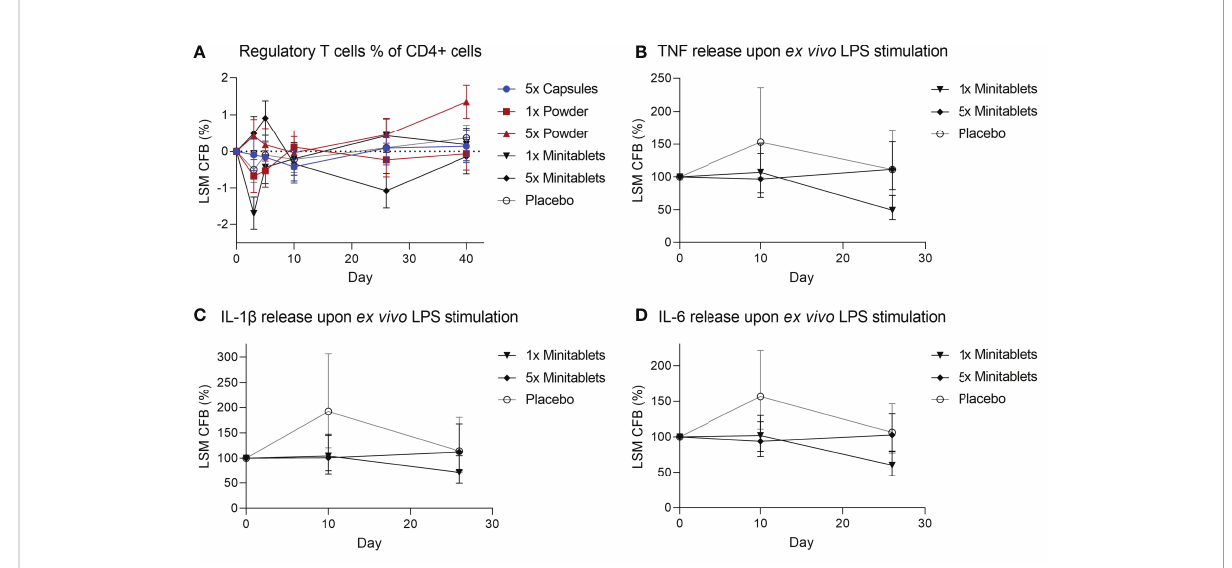
FIGURE 4 (A) Circulating regulatory T cells as percentage of CD4 + T cells from heparinized blood. Monocyte cytokine release assay of (B) tumor necrosis factor, (C) interleukin-1 b , and (D) interleukin-6 release from whole blood cultures after ex vivo lipopolysaccharide stimulation. X-axis represents number of days after initial EDP1066 dose. Data are shown as least squares mean change from baseline ( CFB) with 95% con fi dence interval. LSM, least squares mean; CFB, change from baseline; LPS, lipopolysaccharide; TNF, tumor necrosis factor; IL =